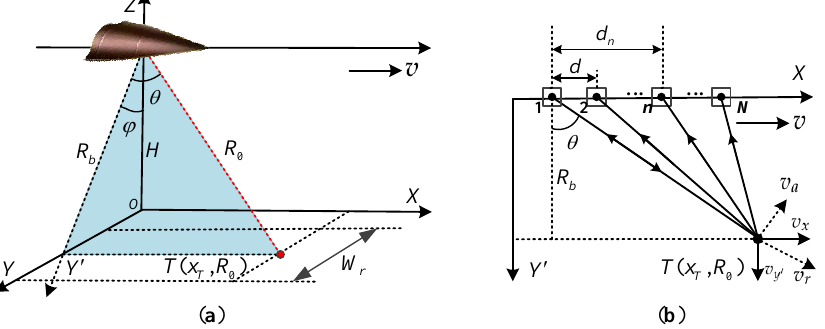
Figure 1. Geometric configuration of the HSV-MC-SAR systems. ( a ) HSV-SAR sketch with high- squint. ( b ) Data acquisition geometry at the slant range plane.